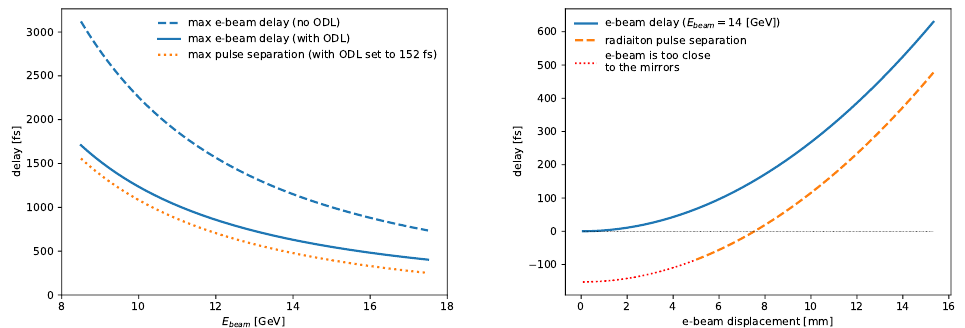
Figure A2. Left plot. Delay, introduced to the electron beam by the chicane operating at maximum magnetic field of 1.2 T, calculated for both geometries. The dotted orange line depicts the maximum pulse separation if the ODL is installed (see text). Right plot. The resulting separation of two SASE pulses from U1 and U2 is approximately given by the sum of tunable positive delay introduced to the electron beam in the magnetic chicane and a fixed − 152 fs negative delay introduced to the radiation pulse in the ODL. The latter, when introduced to delay the radiation beam, poses limits to the minimum electron beam